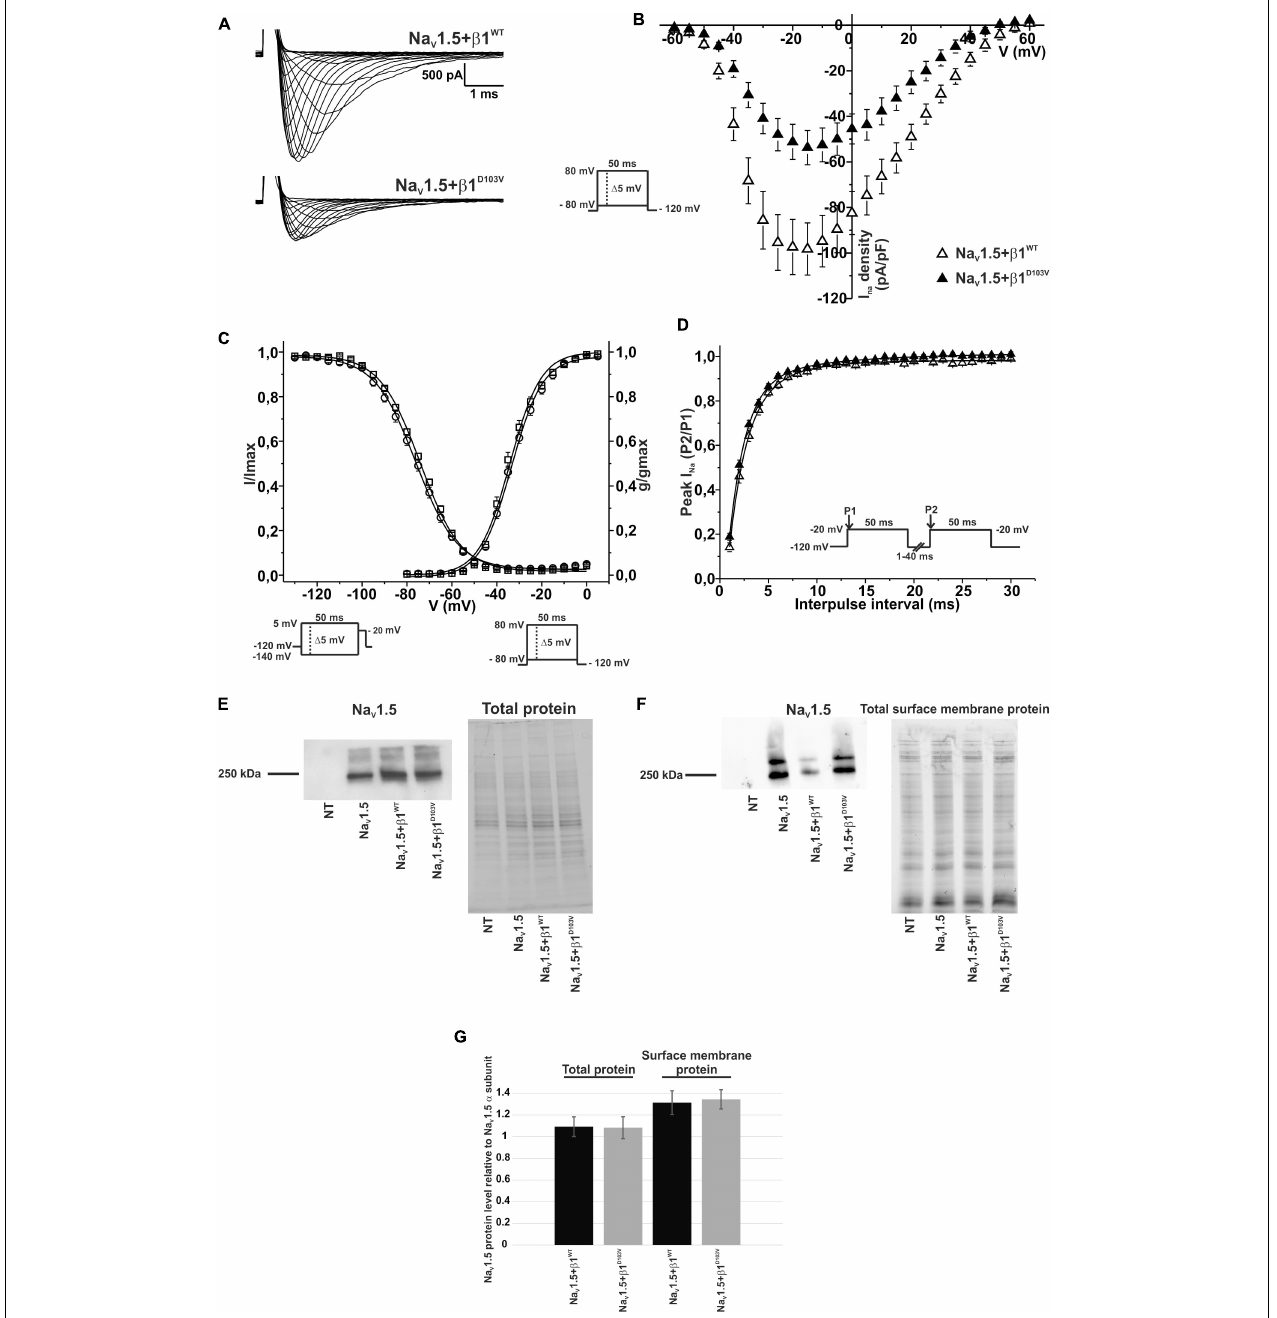
FIGURE 4 | β 1 D103V modifies the gating properties of Na V 1.5 channel. Biophysical properties of sodium currents measured from HEK-293T cells expressing Na V 1.5 alone, or co-expressed with either β 1 WT or β 1 D103V . Whole cell currents were elicited by depolarizing potentials as shown in the insets. Open triangles are used to depict data for Na V 1.5+ β 1 WT and filled triangles for Na V 1.5+ β 1 D103V . Solid lines in panels (C) and (D) represent the fitted curves. Values are expressed as mean ± SEM. (A) Representative whole-cell Na + current traces from HEK-293T cells expressing Na V 1.5+ β 1 WT (top), and Na V 1.5+ β 1 D103V (bottom). (B) Mean current-voltage relationship. I Na amplitude was normalized by the cell capacitance to obtain I Na density values. (C) I Na steady-state voltage dependence of activation and inactivation plots. (D) Recovery from inactivation curves. (E) Western blot detection of Na V 1.5 (left) and corresponding total protein stain-free gel (right), from HEK-293T cells transfected with either Na V 1.5, Na V 1.5+ β 1 WT , or Na V 1.5+ β 1 D103V or non- transfected cells (NT) ( n = 2). (F) Western blot detection of Na V 1.5 after cell surface biotinylation (left) and corresponding total protein stain-free gel (right), from HEK-293T cells transfected with either Na V 1.5, Na V 1.5+ β 1 WT , or Na V 1.5+ β 1 D103V or non-transfected cells (NT). (G) Bar graph depicts the relative protein expression normalized by the Na V 1.5 α subunit of total protein (left, n = 2) and biotinylated protein (right, n = 4) from HEK-293T cells transfected with either Na V 1.5+ β 1 WT or Na V 1.5+ β 1 D103V . Both visible bands from the biotinylated samples were used for quantification, and the ratio was obtained by normalizing each condition with its respective input.